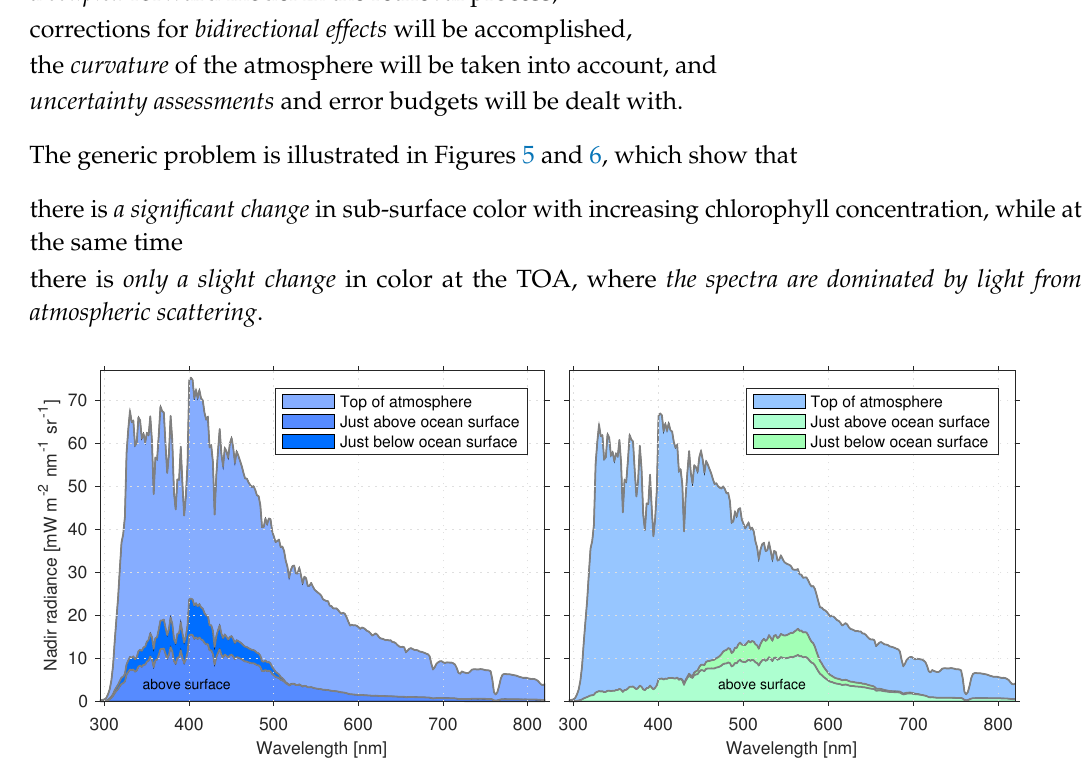
Figure 5. Simulated upward radiance in the nadir direction at the top of the atmosphere and close to the ocean surface. Solar zenith angle = 45 ◦ , US Standard atmosphere with aerosol optical depth = 0.23 at 500 nm. ( Left ) Clear water with chlorophyll concentration = 0.1 mg CDOM443 = 0.003 m − 1 (CCRR bio-optical model). ( Right ) Turbid water with chlorophyll concentration = 10 mg m − 3 , MIN = 0.1 g m − 3 , CDOM443 = 0.1 m − 1 · ·